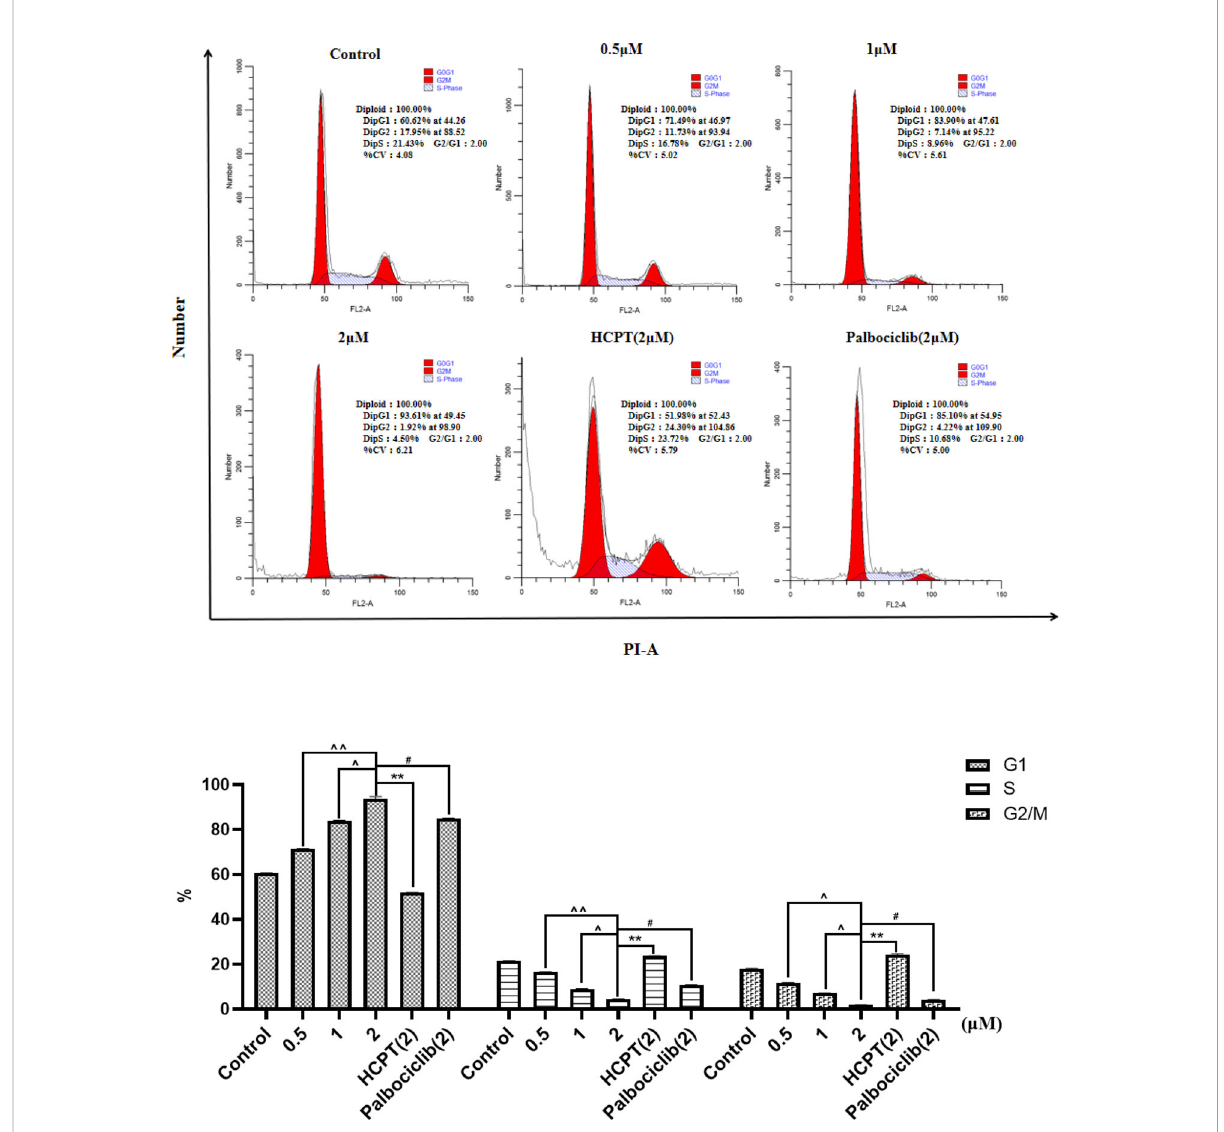
FIGURE 3 Effect of HP-1 on the cell cycle of NCI-H460 cells in concentration dependence. Data shown are the mean ± SD of three independent experiments [** p < 0.01, compared to HCPT; # p <0.05, compared to palbociclib; ^ p <0.05, ^^ p <0.01, compared to HP-1 (2 m